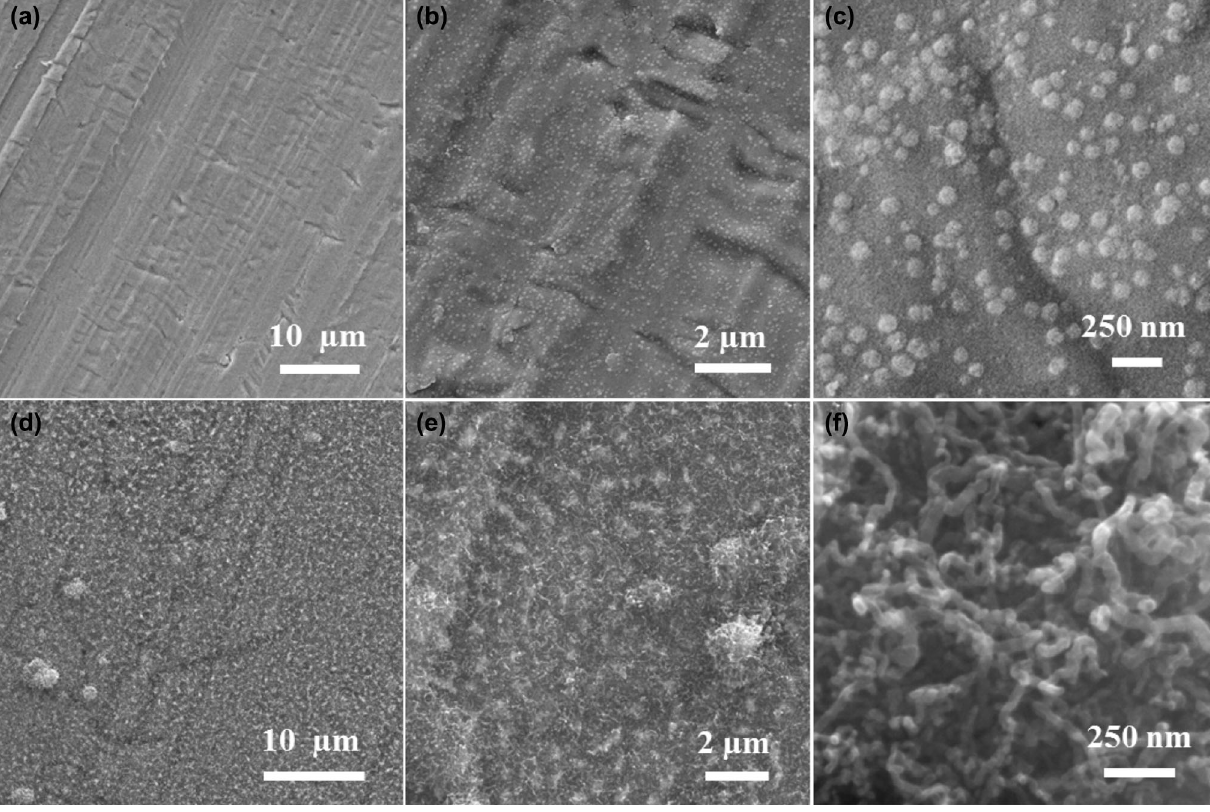
Fig. 2 Morphology of the Fe-growth catalyst and nanocarbon–nanoparticle composites. SEM of as-deposited Fe-catalyst film at different magnifications ( a – c ), and nanocarbon–nanoparticle composite electrodes at different magnifications ( d – f